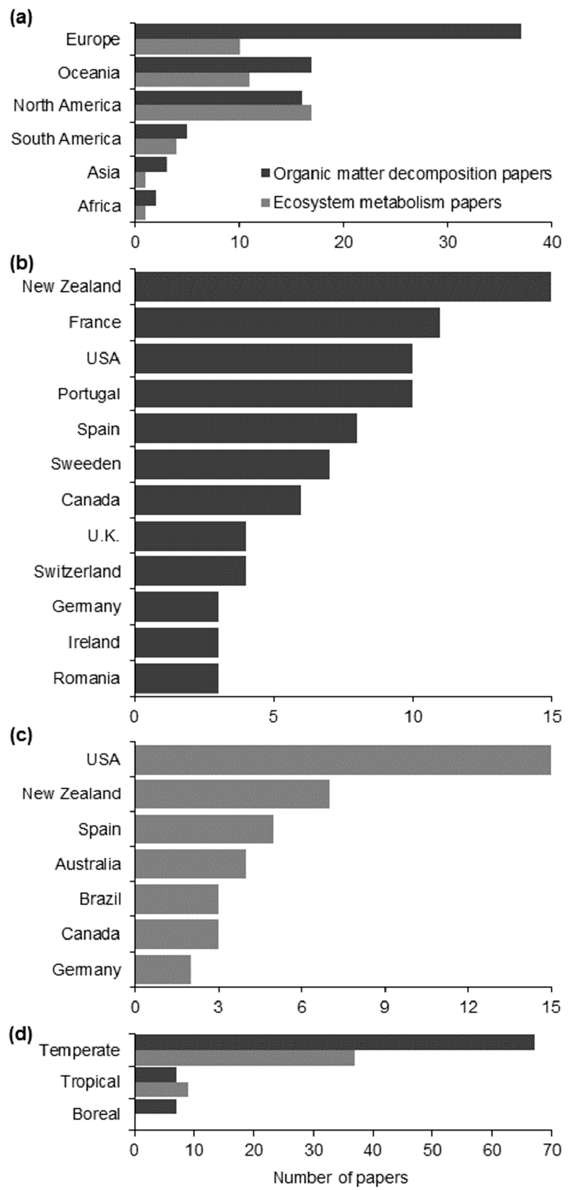
Figure 5. ( a ) Distribution of field studies addressing organic matter decomposition ( n = 81; review and review / methods studies were not considered) or ecosystem metabolism ( n = 44; review and modeling studies were not considered) as bioassessment tools by continent. ( b ) Representation of countries in field studies using organic matter decomposition as a bioassessment tool; only countries represented in ≥ 3 studies are shown (a further 11 countries were represented in 1–2 studies; Table S3). Several studies were carried out in multiple countries (2–9 countries / study) and so the sum of the studies across countries surpasses the number of field studies. ( c ) Representation of countries in field studies using ecosystem metabolism as a bioassessment tool; only countries represented in ≥ 2 studies are shown (a further seven countries were represented in one study each; Table S4). ( d ) Distribution of field studies addressing organic matter decomposition or ecosystem metabolism as bioassessment tools by regions (for the definitions, see Tables S1 and